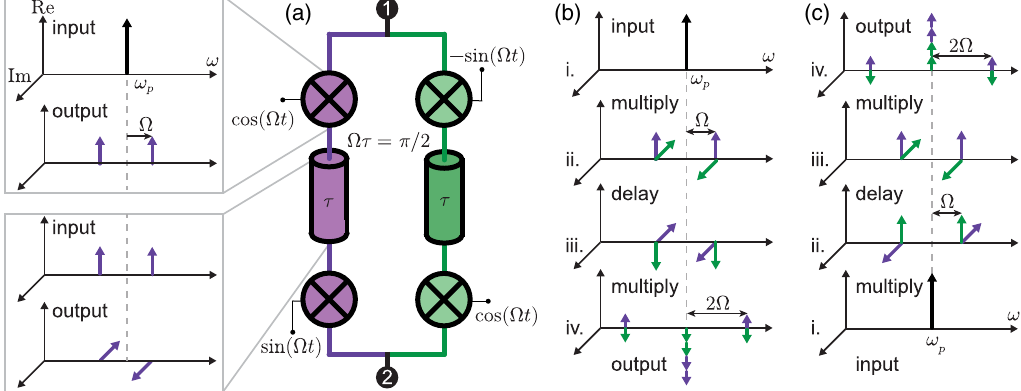
FIG. 2. Conceptual diagram of nonreciprocity generated with frequency conversion and delay. (a) Lumped-element network that forms a gyrator. The insets show how fields are transformed by the network ’ s two components: multiplying elements and delays. In the upper inset, an input field at frequency ω (top panel) is multiplied by cos ð Ω t Þ to create a field with spectral components at ω p (bottom panel). The real and imaginary axes of the plot show the phase of these spectral components in a frame rotating at ω lower inset, a delay of length τ ¼ π = 2 Ω advances or retards the phase of spectral components at ω (b) Calculation of the forward-scattering parameter for the network in (a), by following an incident field at frequency ω through the device. Purple (green) arrows indicate fields propagating in the left (right) arm of the network. Fields are forward transmitted with amplitude and frequency unchanged, but phase shifted by π . (c) Backward transmission through the network in (a). Fields are transmitted with amplitude, frequency, and phase